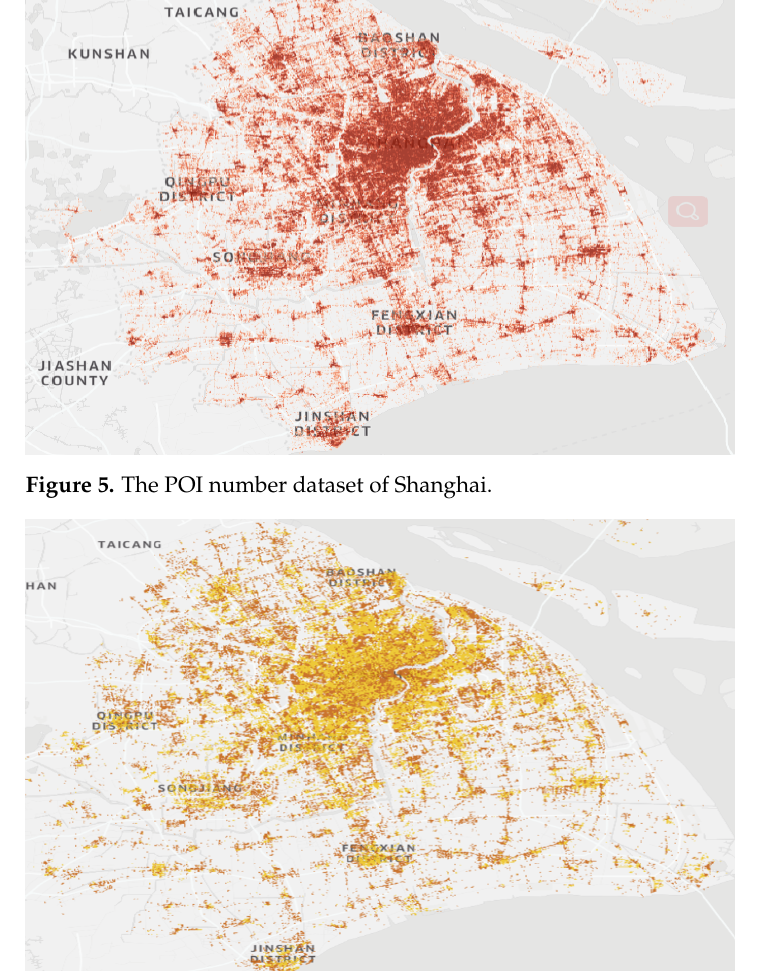
Figure 6. The working/living area dataset of Shanghai, where yellow refers to living area and red to working area.